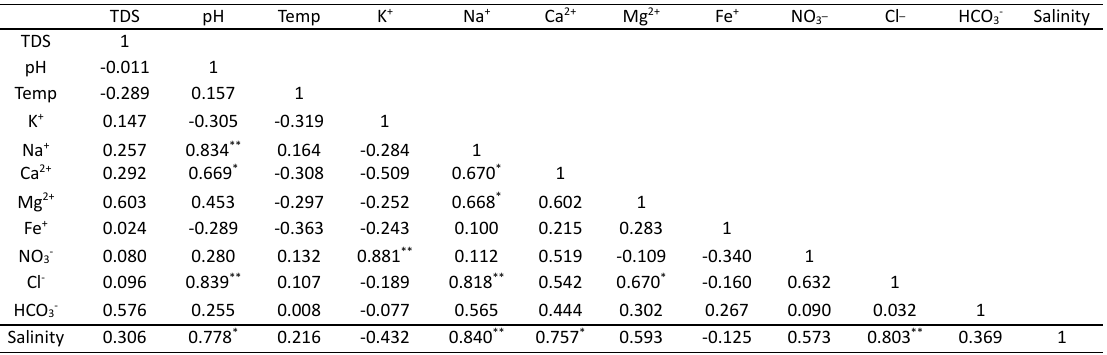
Table 3: Pearson correlation coefficients for 10 variables of water samples in dry season